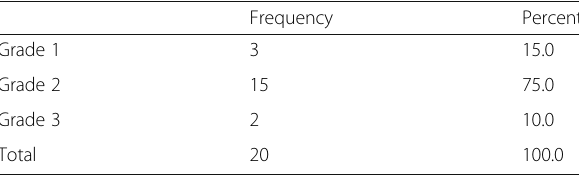
Table 3 The total numbers and percentage of different grades of